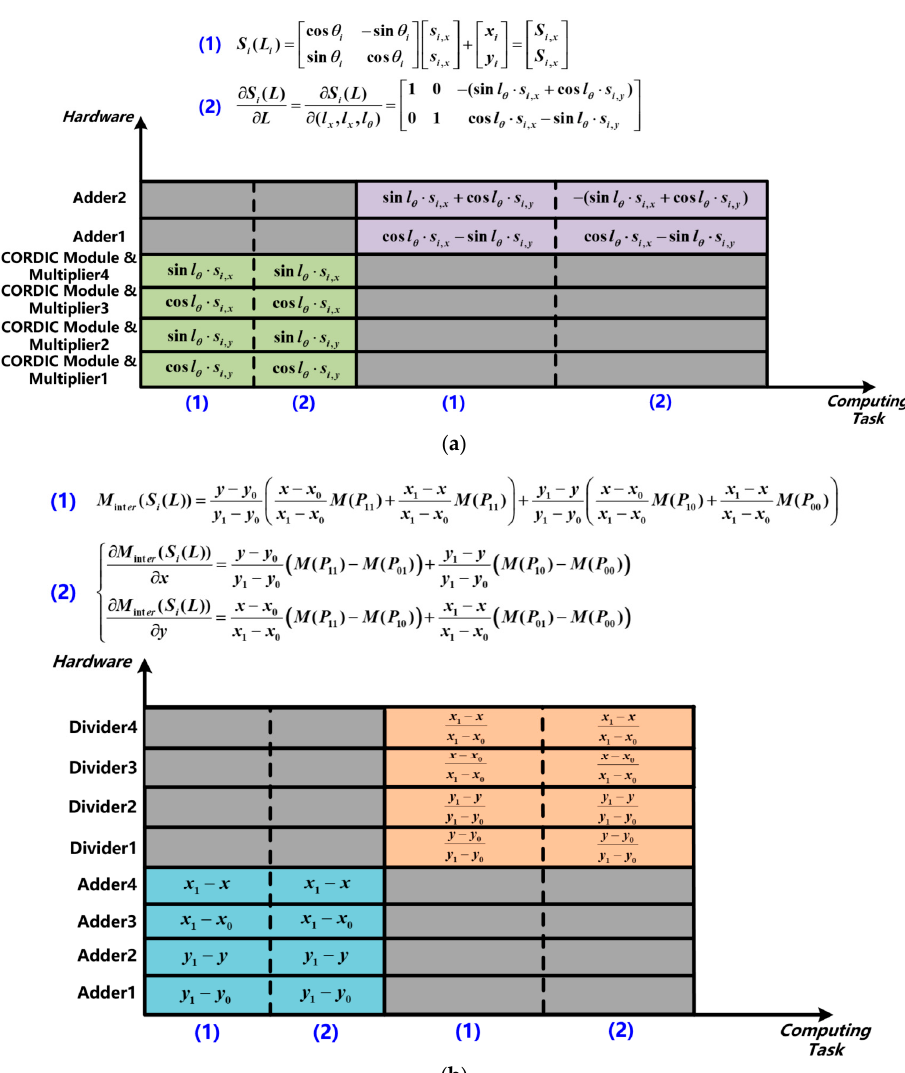
Figure 10. Hardware reuse scheme in ( a ) Subtask 1 and ( b ) Subtask 3 of the proposed NLO-CSM hardware accelerator design.